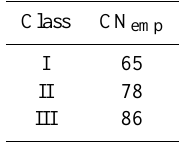
Table 2. The highest values of CN emp for the three classes anal-